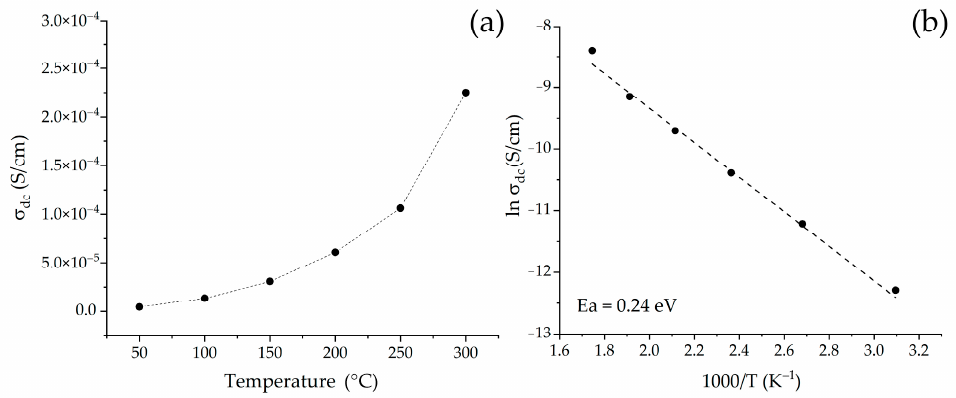
Figure 8. Temperature dependence of σ dc ( a ) and ln σ dc of the studied sample ( b